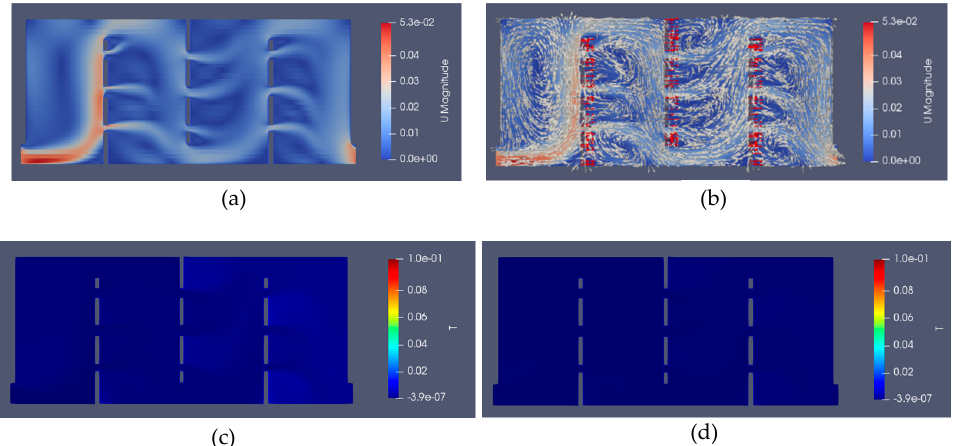
Figure 12. Typical velocity magnitude and concentration distributions in the contact tank with full width slots (w = 230 mm, h = 12, 16, 14 mm random placement) case: ( a ) Flow distribution; ( b ) Flow distribution with velocity vectors; ( c ) Concentration distribution at 200 s; ( d ) Concentration distribution at 300 s.